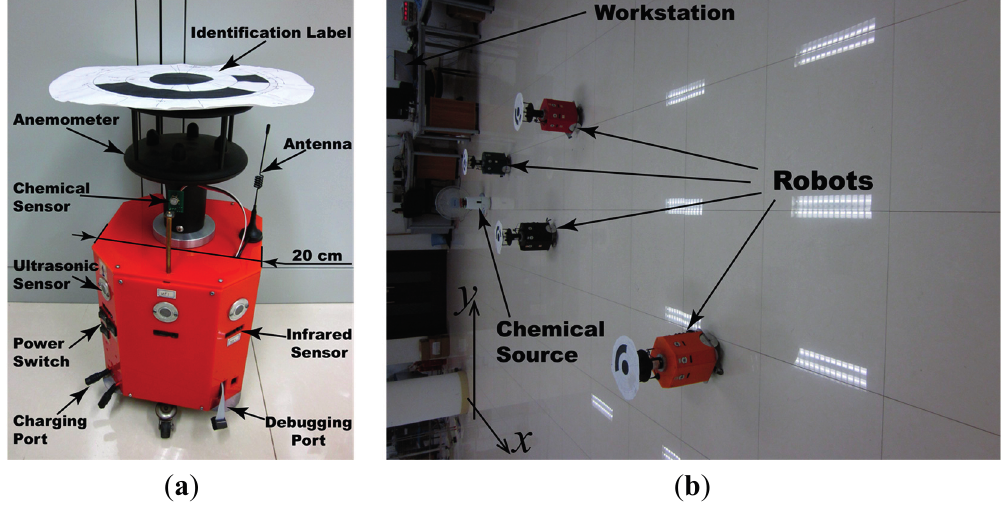
Figure 7. Mobile olfactory robots used in the experiments. ( a ) One of the MrCollie robots; ( b ) a scene of controlling the robots in the